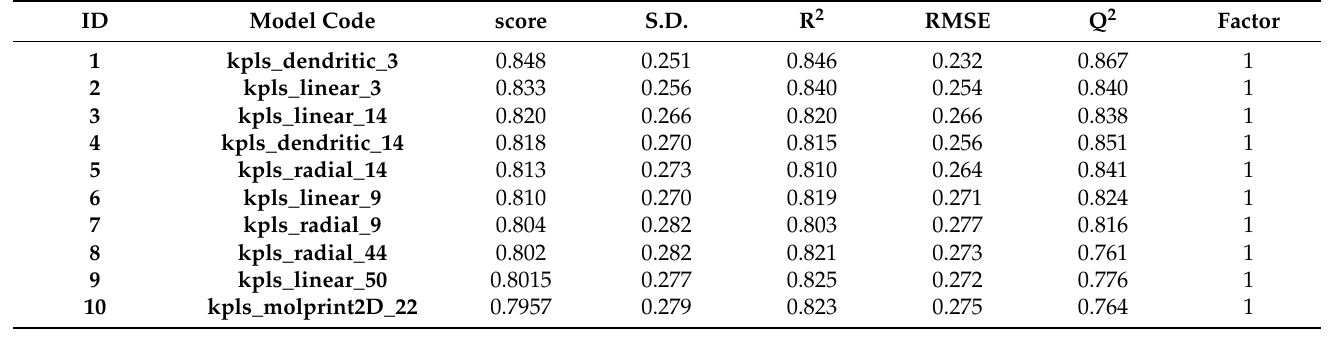
Table 5. Model report of best ten QSAR model generated by AutoQSAR.